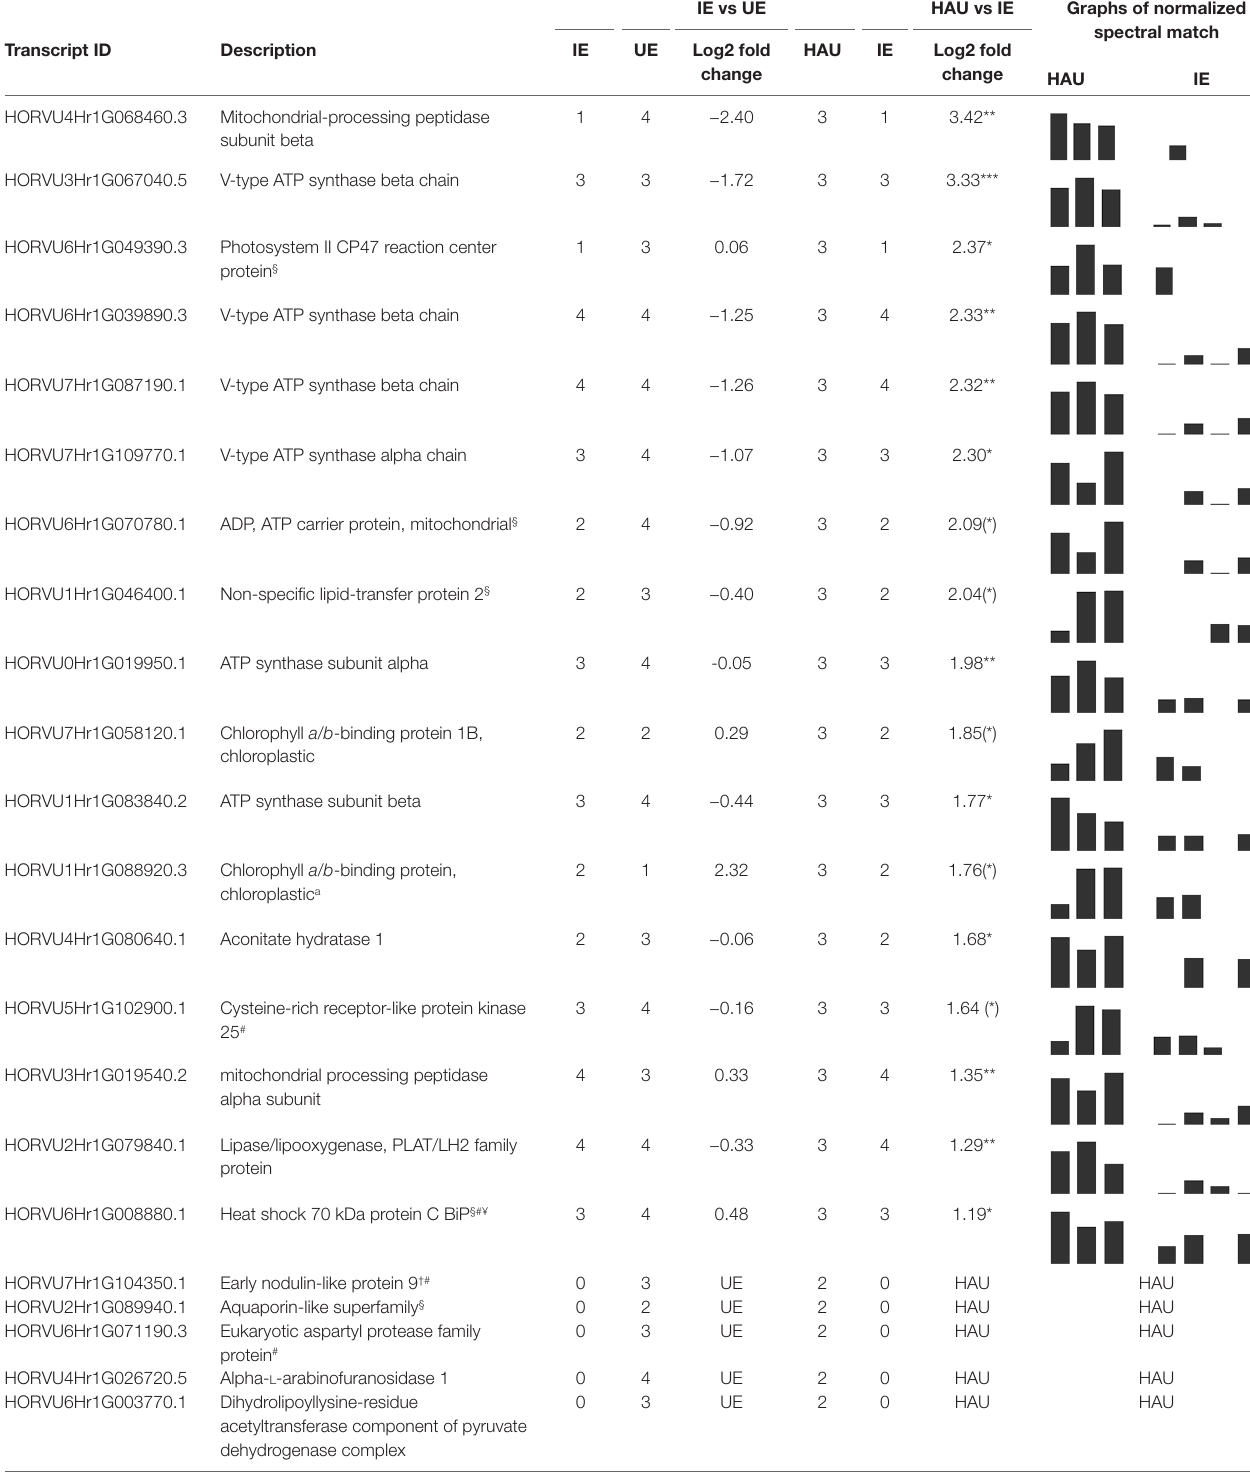
TABLE 2 | List of differentially abundant proteins (DAPs) with a significant increase in relative abundance in HAU when compared with IE (HAU vs IE comparison). The number of replications per experimental set (Rep count) and log 2 fold change (average of spectral count) or exclusivity in one set are reported, for both HAU vs IE and IE vs UE